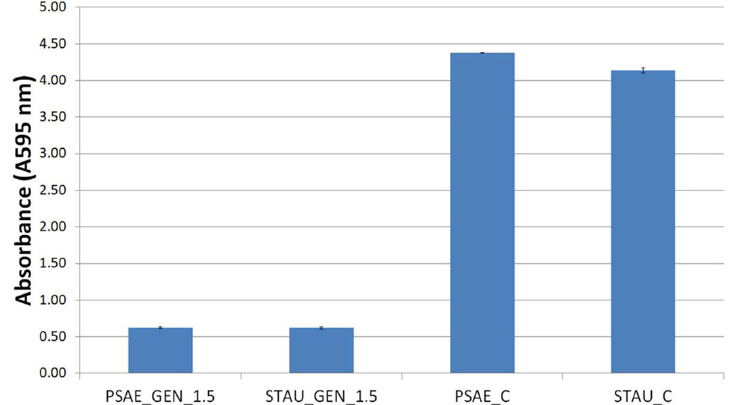
Figure 8. The eradication of biofilms by MA_GEN_1.5 measured by spectrometry. These results showed that the PCL nanofibers substrates with SLP_GEN_1.5 not only prevents biofilm growth but eradicates biofilm structure. P. aeruginosa (PSAE) and S. aureus (STAU).